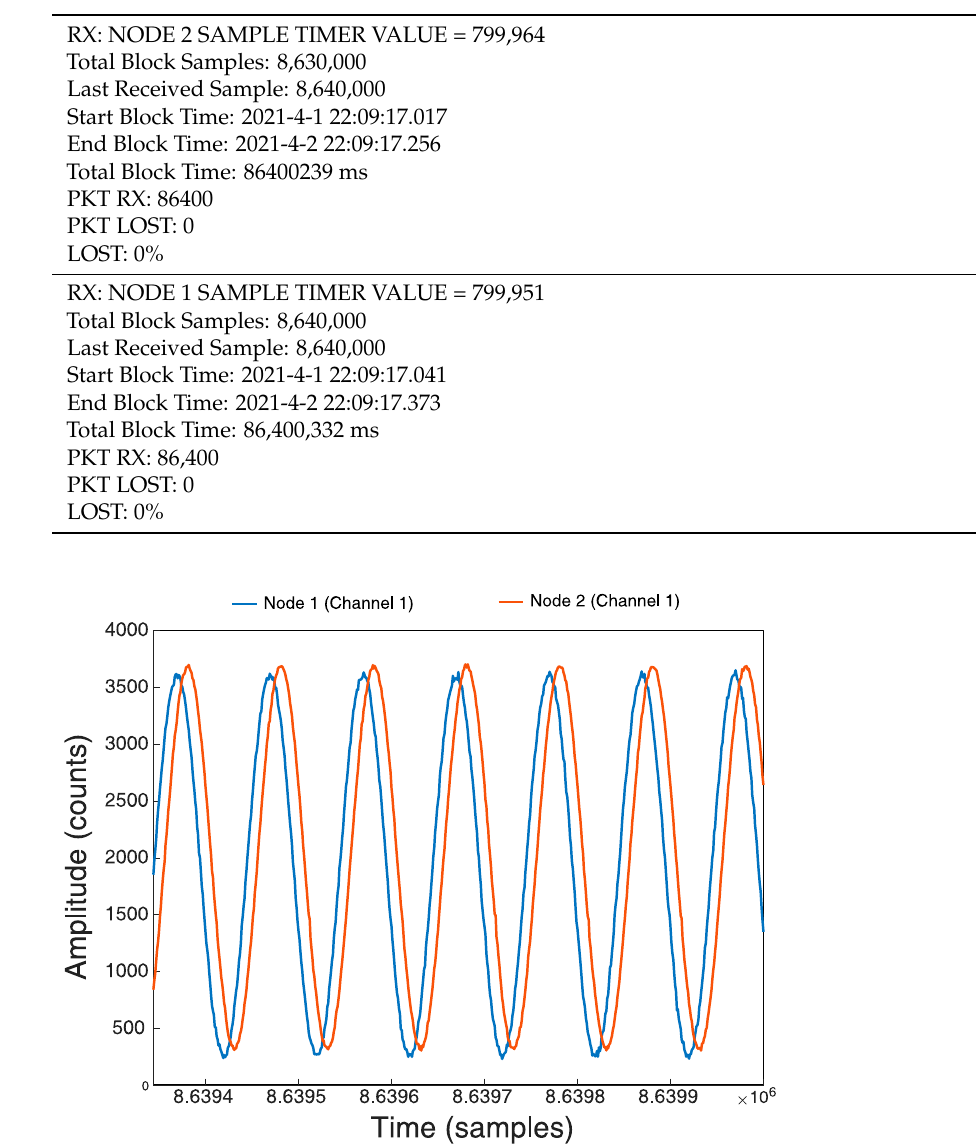
Table 5. Results of 24 h with Stop-and-Go = 8 h.